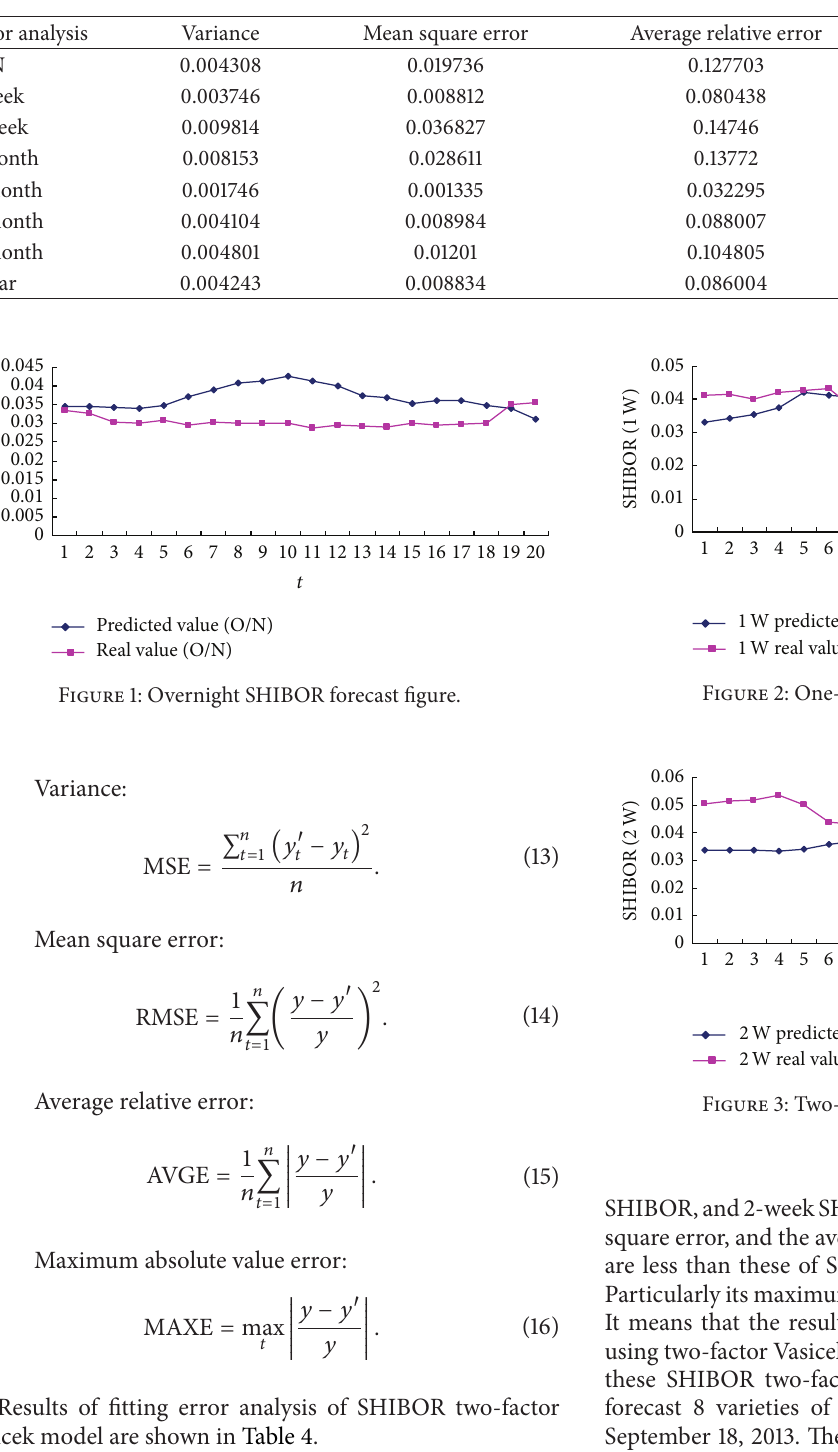
Table 5: Analysis results of prediction errors of SHIBOR two-factor Vasicek model.